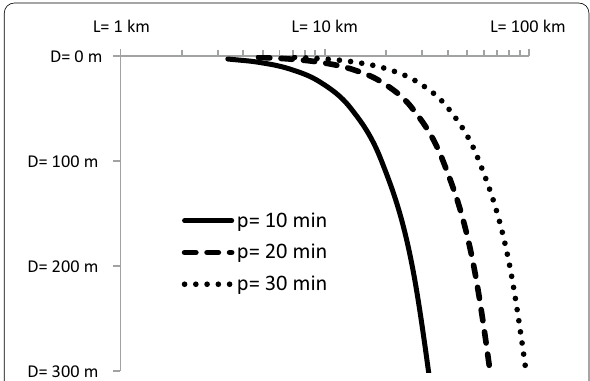
Fig. 1 The wave period p as a function of the wave length L and the water depth D , using Airy’s theory for progressive shallow waves (tsunamis), Katopodes (2019), Eq. 3.44. A 10–min wave period is the maximum for tsunamis in Lake Brienz